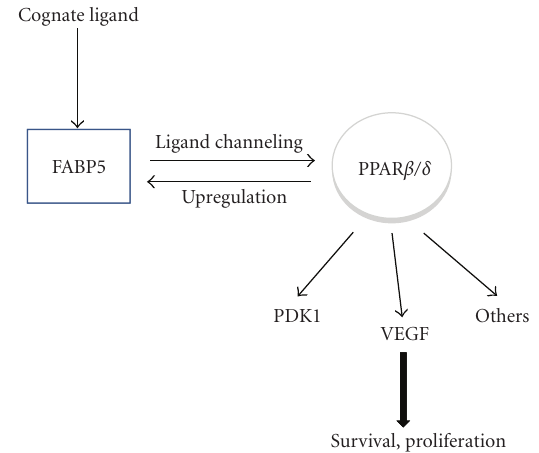
Figure 5: A model for the cooperation between FABP5 and PPAR β/δ which enhances prostate cell survival and proliferation. Upon binding to a cognate ligand, FABP5 translocates to the nucleus where it directly delivers the ligand to its cognate nuclear receptor, PPAR β/δ . Activation of PPAR β/δ results in upregulation of FABP5. A positive feedback loop is thus established: PPAR β/δ activation induces the expression of FABP5 which, in turn, enhances the transcriptional activity of the receptor. The FABP5/PPAR β/δ pathway induces the expression of PPAR β/δ target genes involved in cell survival, for example, PDK1, and growth and angiogenesis, for example, VEGF, and thus contributes to prostate cancer